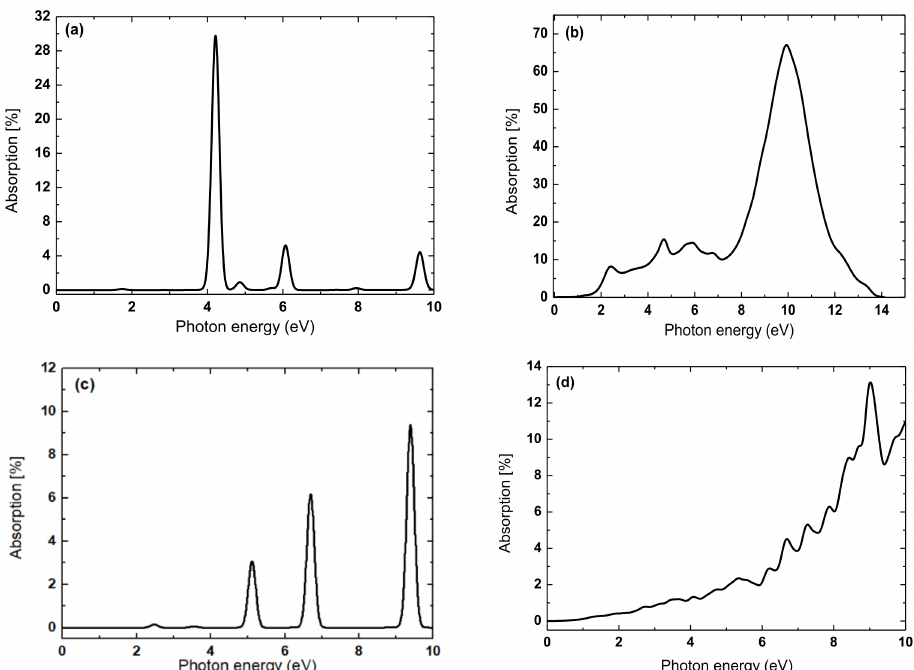
Figure 7. Structure dependence of optical photoabsorption spectra. Top panels show the spectra of the sp 3 -hybridized C–C dimer ( a ) and the carbon nanoline ( b ). Bottom panels show the absorption spectrum for the Ta-As dimer ( c ) and the TaAs nanocluster ( d